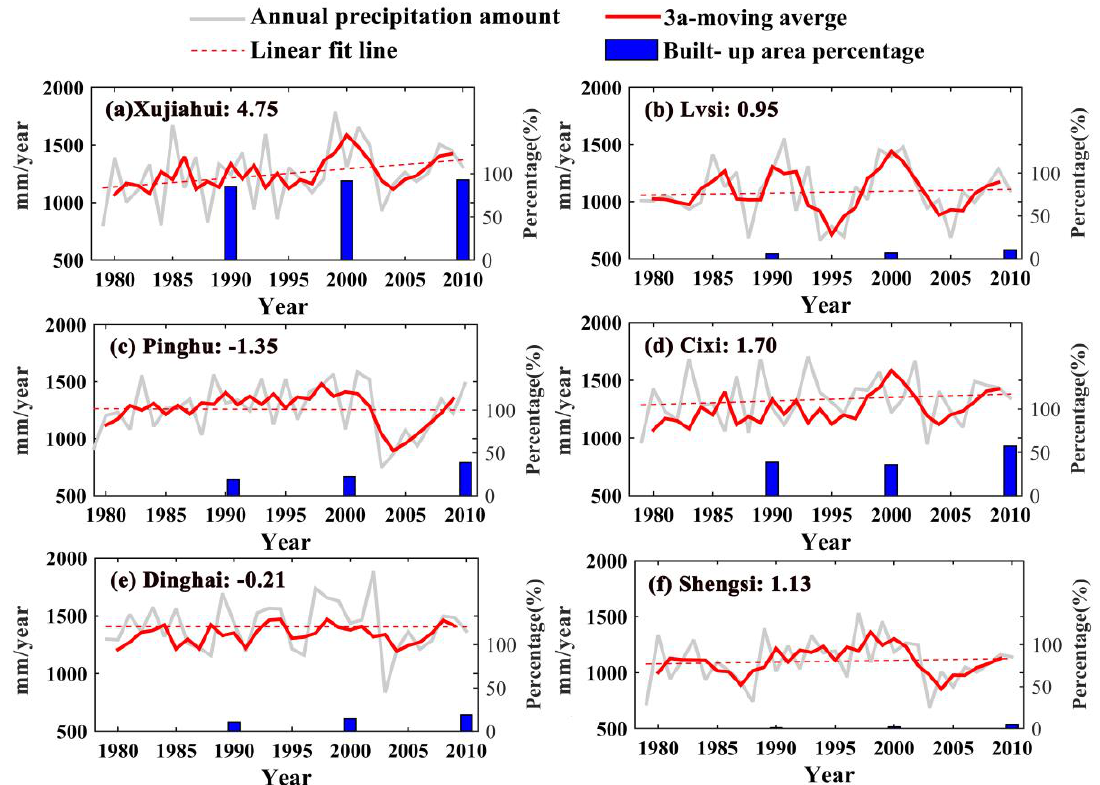
Figure 15. The time series and estimated trends for annual precipitation amounts from 1979 to 2010 and the percentage of the built-up area from 1990 to 2010 for: ( a ) Xujiahui; and five coastal sites (( b ) Lvsi; (c) Pinghu; ( d ) Cixi; ( e ) Dinghai; and ( f ) Shengsi).